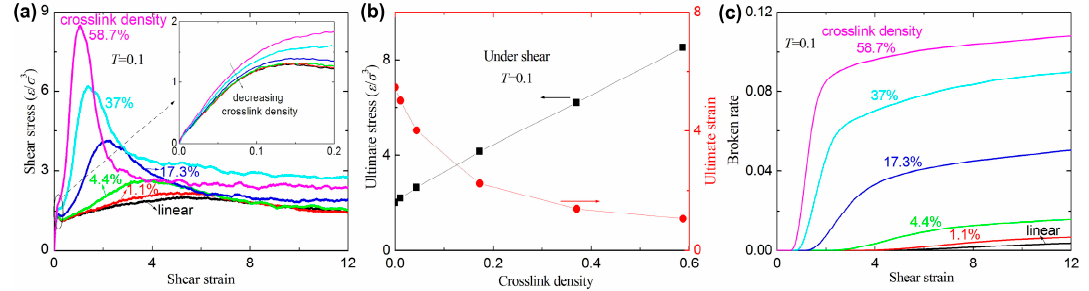
Figure 7. ( a ) The shear stress ‐ strain curves with different crosslink densities at temperature T = 0.1; ( b ) the ultimate stress and the ultimate strain versus crosslink density; and ( c ) the broken ratio versus crosslink density at temperature T = 0.1.